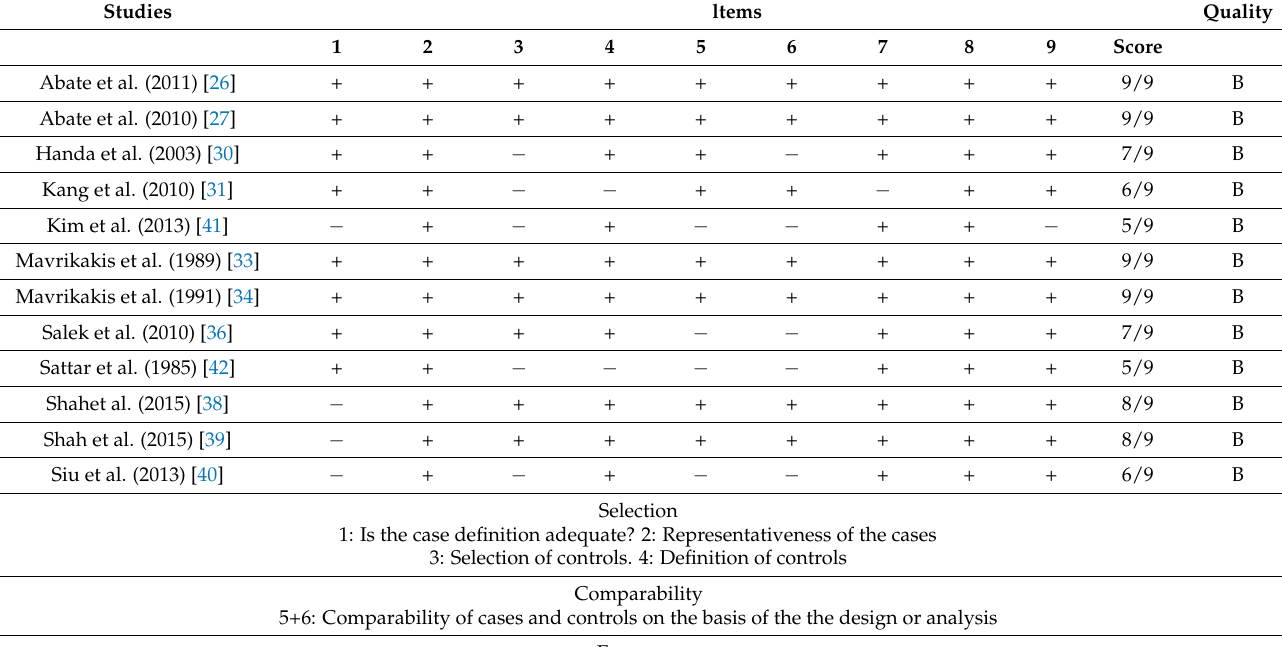
Selection 1: Is the case definition adequate? 2: Representativeness of the cases 3: Selection of controls. 4: Definition of controls Comparability 5+6: Comparability of cases and controls on the basis of the the design or analysis Exposure 7: Ascertainment of exposure 8: Same method of ascertainment for cases and controls 9: